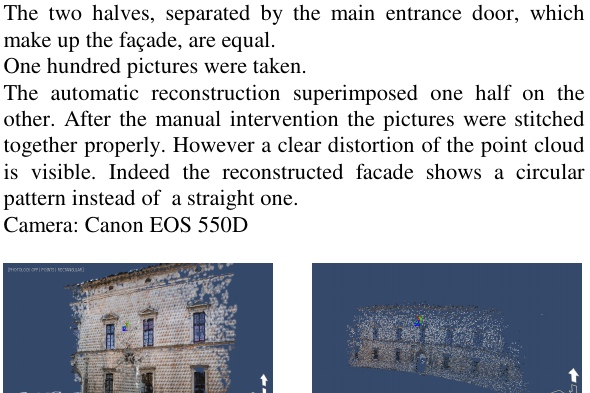
Figure 6. Maggiore Square, Bologna, Automatic Reconstruction